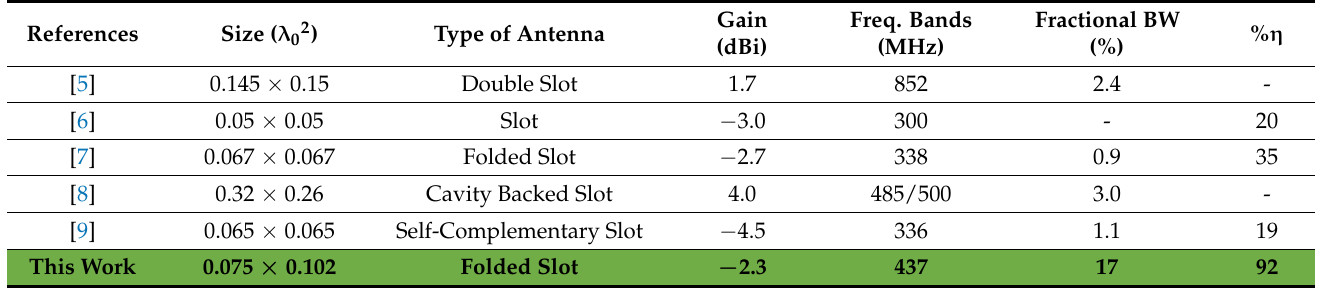
Table 1. Comparison between the proposed CubeSat MIMO antenna and other works.